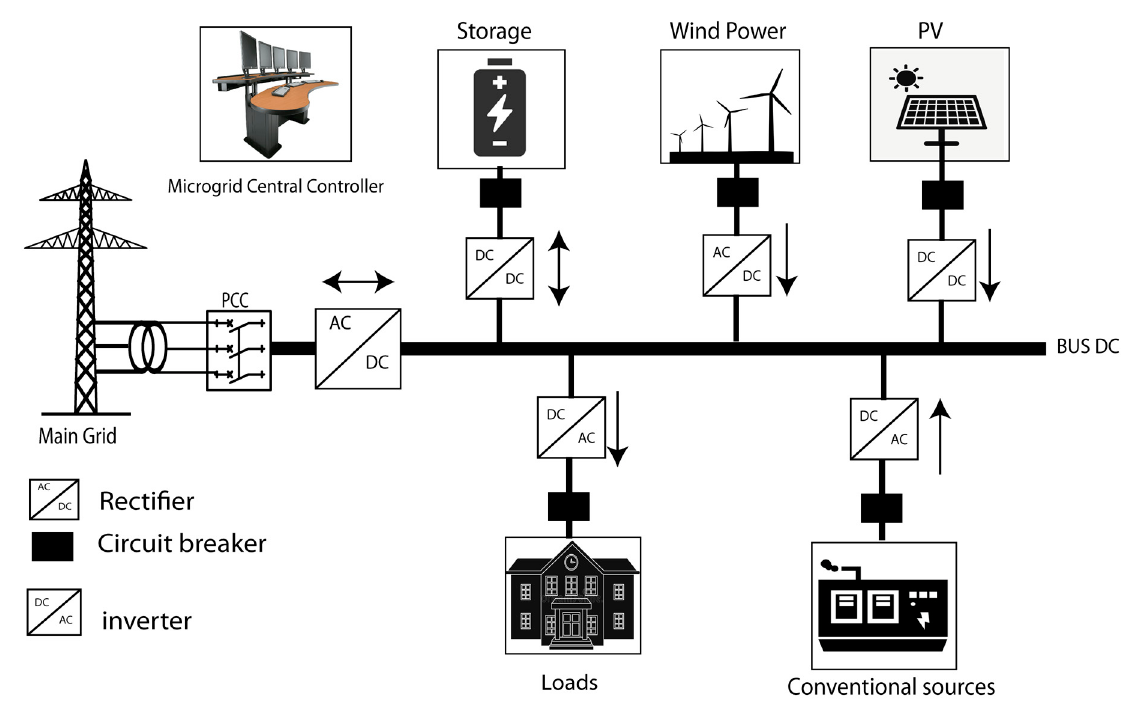
Figure 1. The architecture of a microgrid.